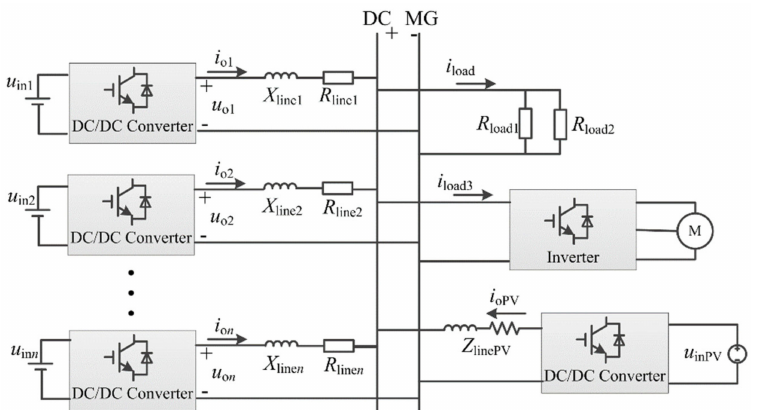
Figure 1. DC microgrid simplified structure with multiple distributed generations.